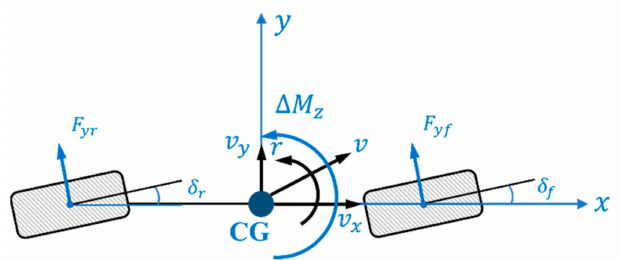
Figure 6. Single-track model for 4WID-4WIS